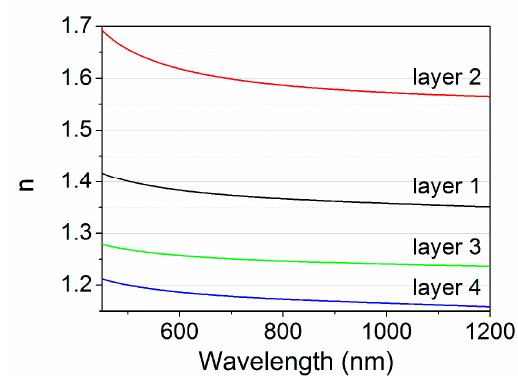
Figure A2. Refractive index n dispersion for the DBR layers reported in Figure A1.